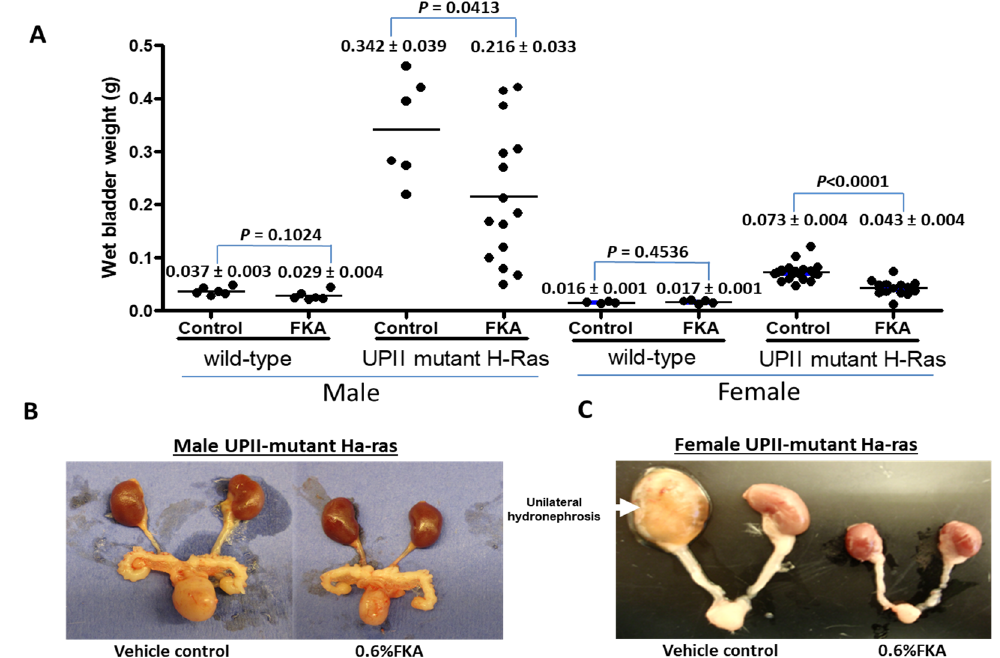
Figure 2. The chemopreventive efficacy of dietary FKA on urothelial tumorigenesis of homozygous UPII-mutant Ha-ras transgenic mice. ( A ) Bladder weights of wild-type and UPII-mutant Ha-ras transgenic mice fed with control diet or diet containing 0.6% FKA for 6 months. Mean bladder weight ± SD. ( B , C ) Macroscopic examination revealed enlarged bladders, ureters, and kidneys in control diet groups compared to FKA diet groups in both male and female mice.